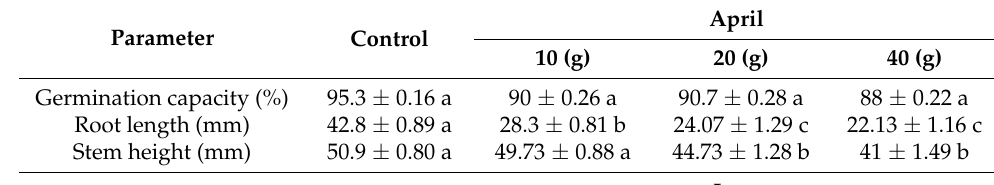
Table 1. Effect of volatiles released by Prunus serotina leaves (10, 20 and 40 g), collected in three months of the growing season (April, June and August), on germination and growth parameters of Pinus sylvestris seedlings. Data are mean ± SE. Different letters (a, b, c) following values in rows indicate significant differences for different weight of P. serotina leaves determined in Tukey HSD or Kruskal–Wallis tests, with p ≤ 0.05; n =